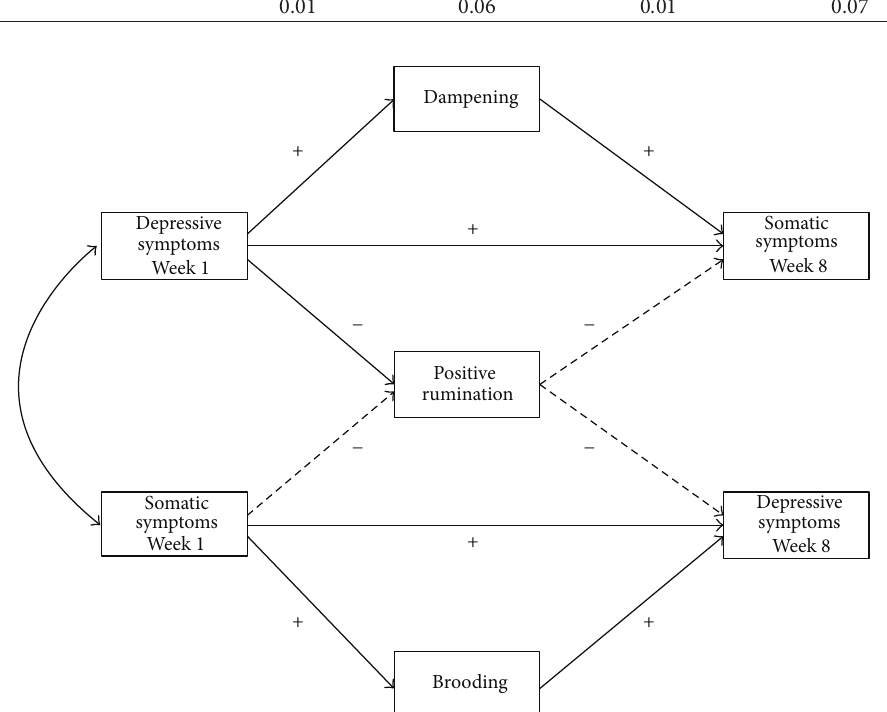
Figure 2: Relationships between depressive and somatic symptoms as mediated by dampening, positive rumination, and brooding. Dashed lines indicate